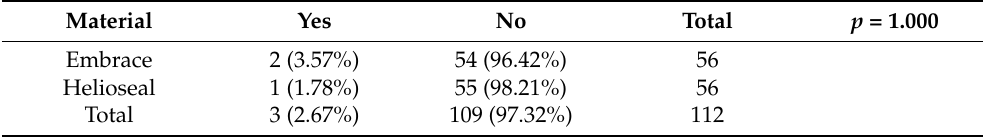
Table 6. Assessment of carious lesion after 12 months.